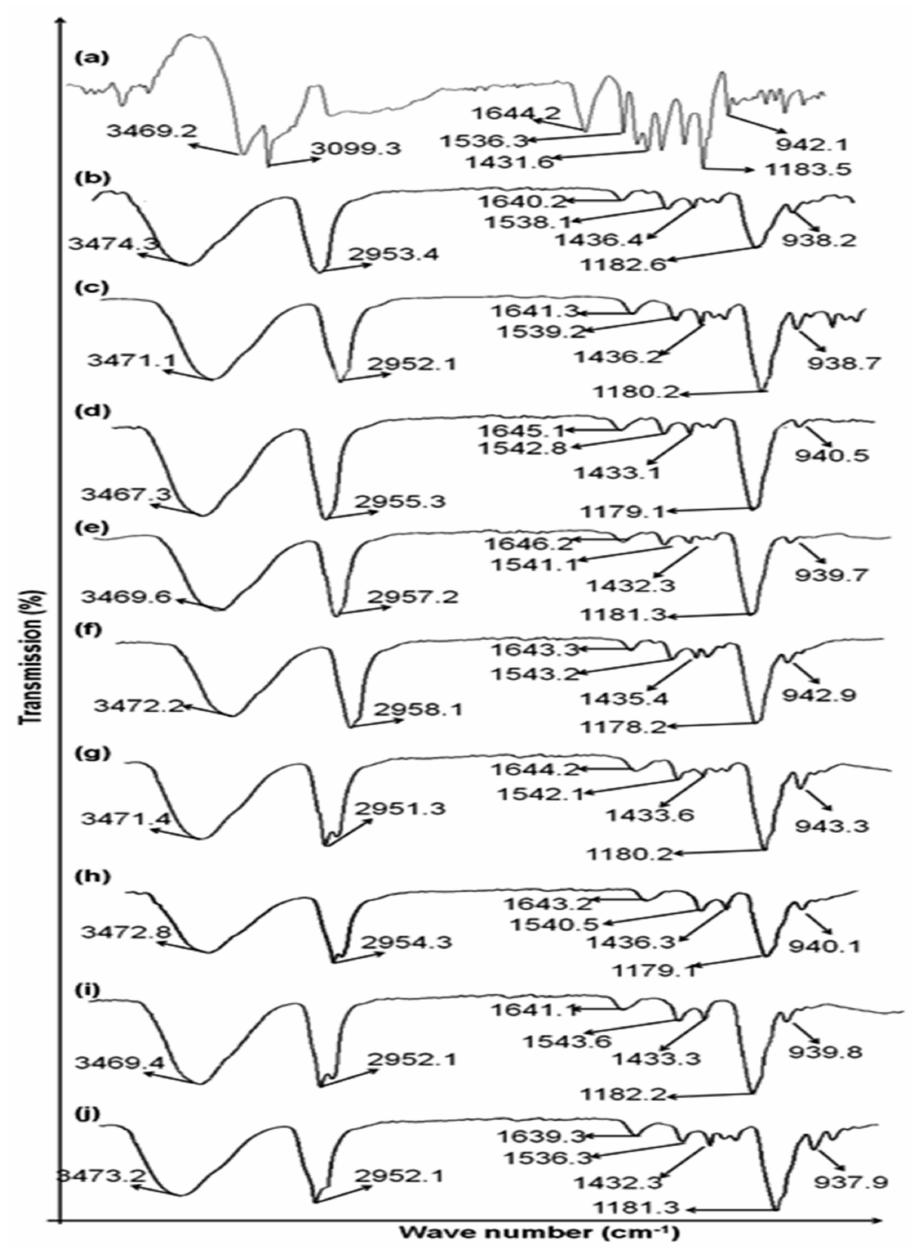
Figure 1. ATR–FTIR spectrum ( a ) Methotrexate ( b ) F1 ( c ) F2 ( d ) F3 ( e ) F4 ( f ) F5 ( g ) F6 ( h ) F7 ( i ) F8 ( j )